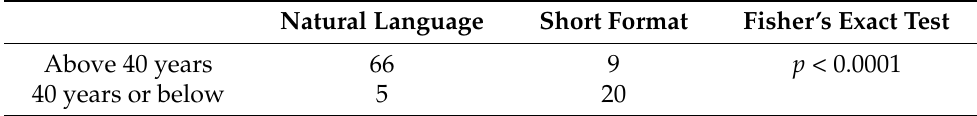
Table 2. Association between preferred way of requesting information via SMS and age of